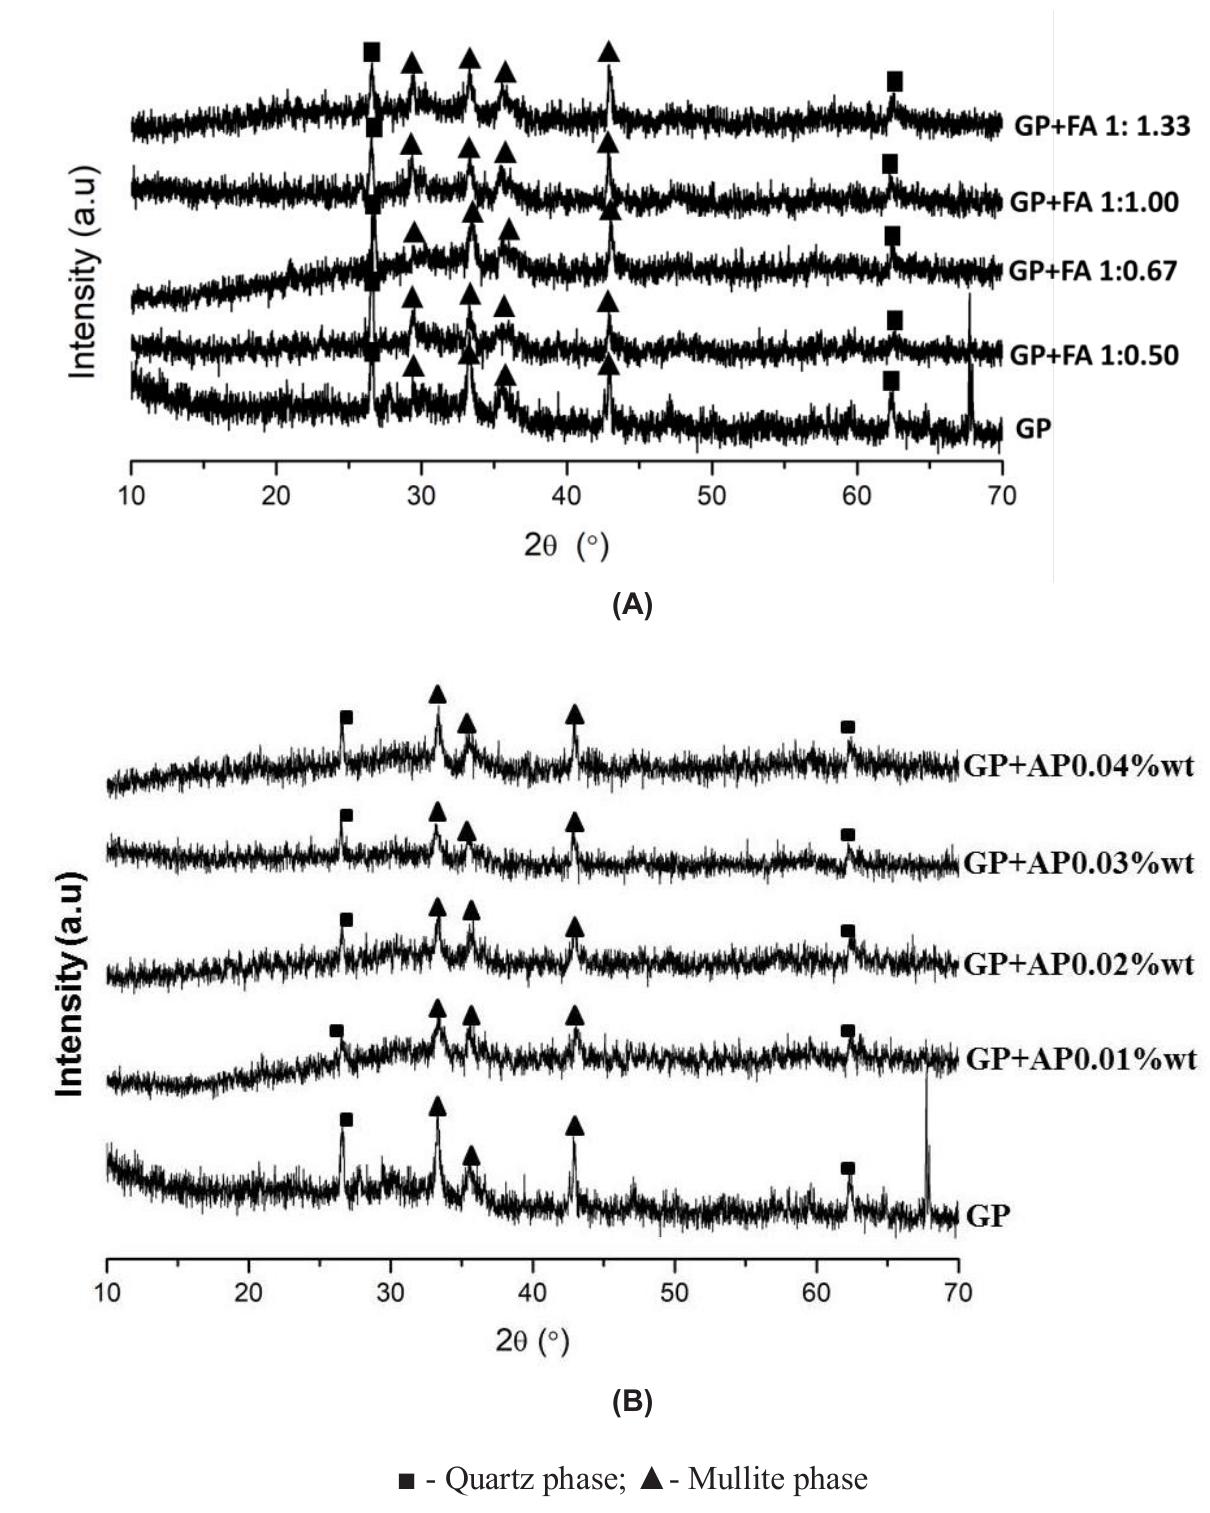
Figure 1: The diffractogram of (A) geopolymer without and with foaming agent addition and (B) geopolymer without and with the addition of aluminum